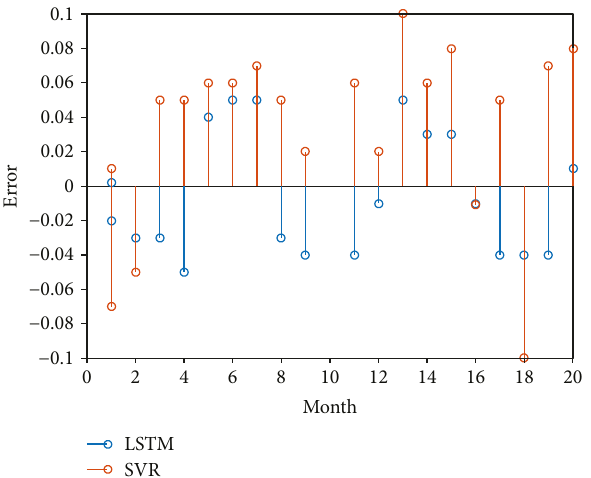
Figure 11: Comparison of prediction errors between SVR and LSTM.